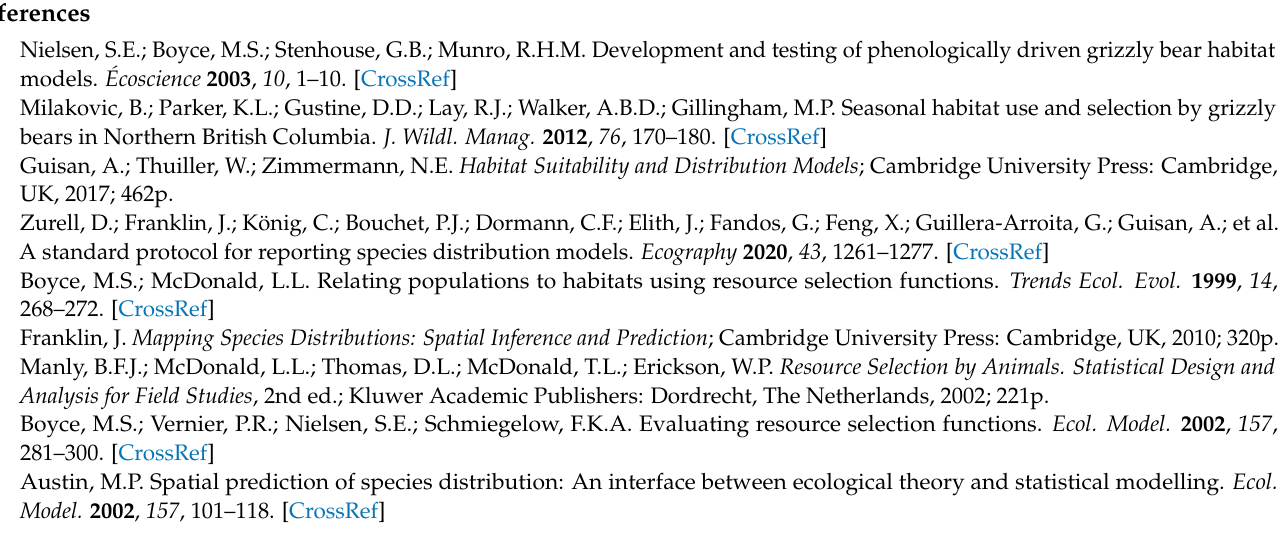
Figure A6. The global map of brown bear food resource richness in the Central Forest State Nature Reserve (West-European Russia) in 2008–2020 showing individual food objects. The colours indicate different combination of food resources (one to seven) per pixel among the following items: Apiaceae forbs, aspen, bilberry, cranberry, hazel, rowan, domestic apple, anthills, and moose. The CFNR core area is inside the red line polygon; the CFNR buffer zone is outside the red line polygon.